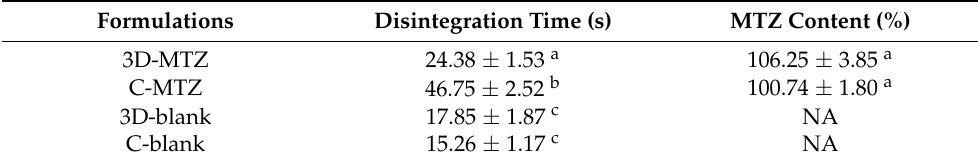
Table 3. Disintegration time and MTZ content of ODFs. Formulations